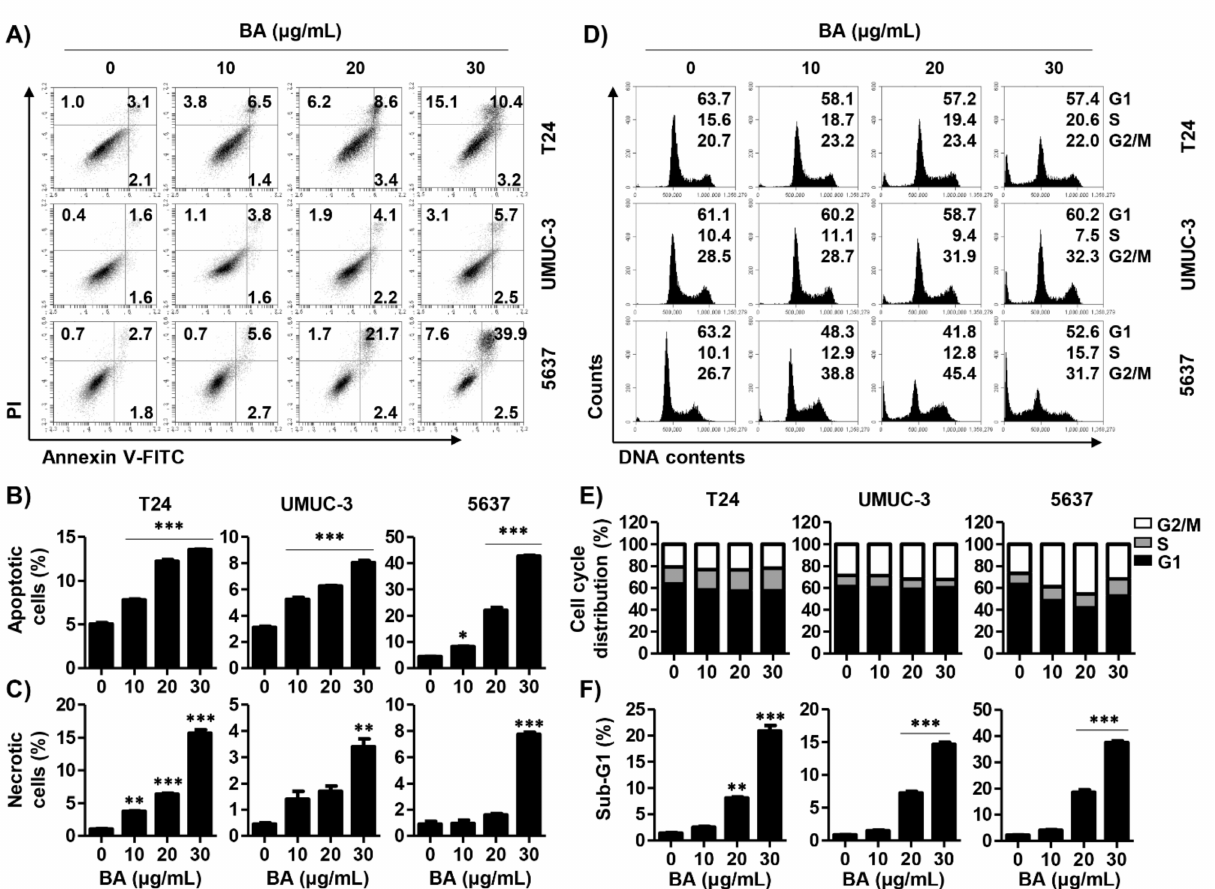
Figure 2. BA induces apoptosis, necrosis, and cell arrest in human bladder cancer cells. Cells were treated with BA (0, 10, 20, and 30 µ g/mL) for 48 h. ( A ) Cells were collected and stained with annexin V-fluorescein isothiocyanate (FITC)/propidium iodide (PI), and then early apoptotic (annexin V + /PI − ), late apoptotic (annexin V + /PI + ), and necrotic (annexin V − /PI + ) cells were measured by flow cytometry. ( B , C ) The proportion of apoptotic and necrotic cells were quantified. The percentage of apoptotic and necrotic cells are shown as the mean ± SD ( n = 3). ** p < 0.01 and *** p < 0.001 vs. untreated control group. ( D ) The cell cycle distribution was detected using flow cytometer. ( E , F ) The percentages of cell cycle distribution and sub-G1 phase cells were quantified. The percentage of cell distribution and sub-G1 phase are shown as the mean ± SD ( n = 3). ** p < 0.01 and *** p < 0.001 vs. untreated control